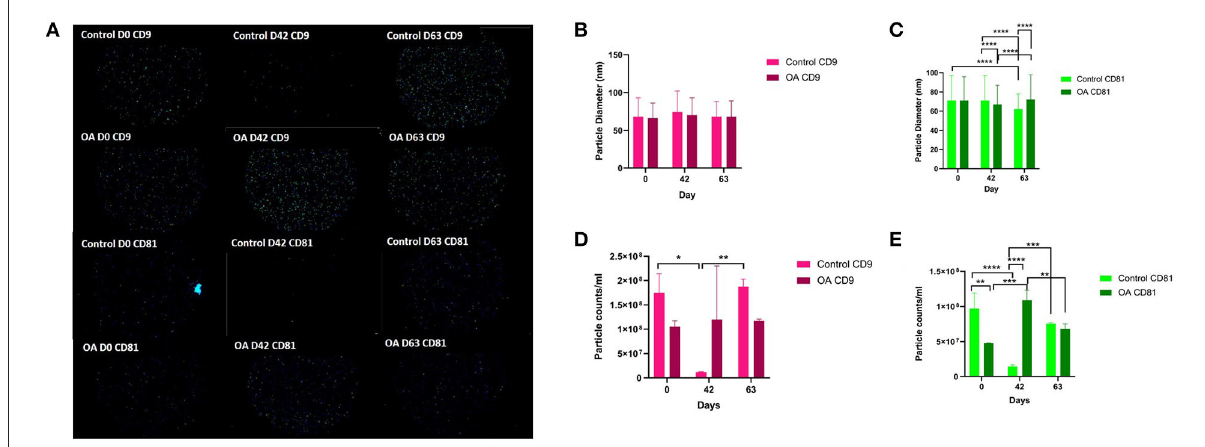
FIGURE3 Visualisation, sizing, and enumeration of SF-derived EVs from control and osteoarthritic (OA) joints using Exoview at selected time points. All the data were adjusted for dilution of the sample onto the chip. Average of three technical replicates was run. Particle number was quantified by the number of particles in a defined area on the antibody capture spot. All bars are means and error bars standard deviation. Each sample represents a pool of all the four horses prior to induction (day 0) and on days 42 and 63 after induction of OA (A) Fluorescent image of a representative spot for each sample. (B,C) Sizing of (B) CD9- and (C) CD81-labelled EVs normalised to MIgG control. Limit of detection was 50–200nm. (D,E) Counting of (D) CD9- and (E) CD81-positive particles after probing with fluorescent tetraspanin antibodies. Statistical analysis was conducted in